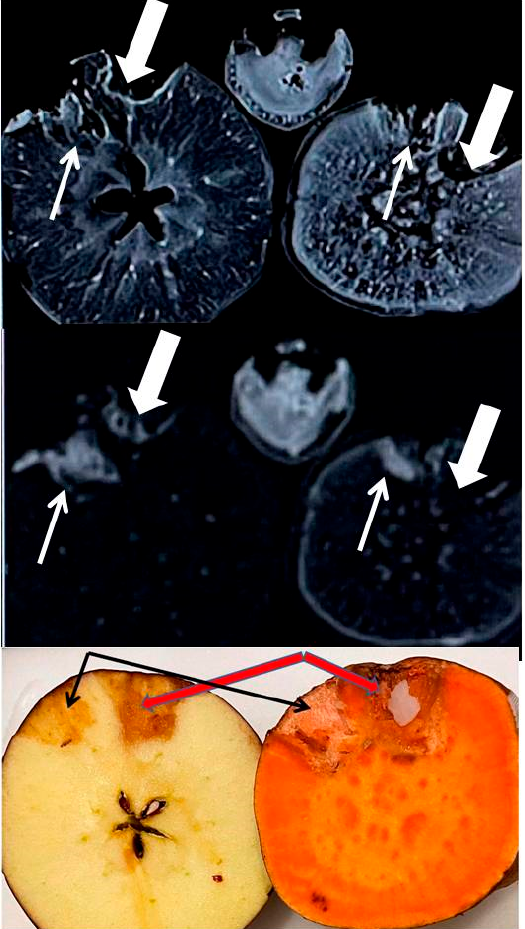
Figure 4. High Field (3T) MR images of the mineral-rich apple (left) and sweet potato (right), each with two carved wells infused five days prior with iodinated contrasts Omnipaque (240, thin arrow and 350, thick arrow). Also shown is the image of a banana at the superior/middle aspect.